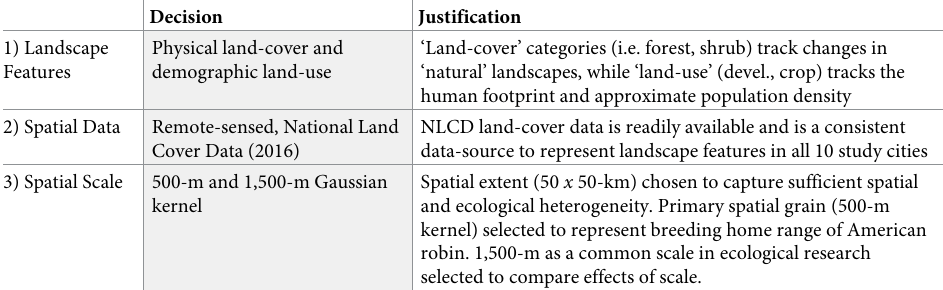
Table 2. Landscape analysis decision